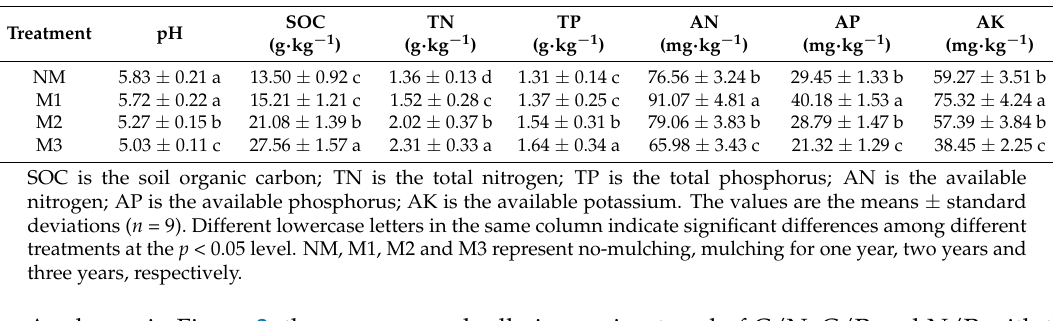
Table 2. Selected nutrient contents of soil in P. edulis stands of different mulching years. Treatment